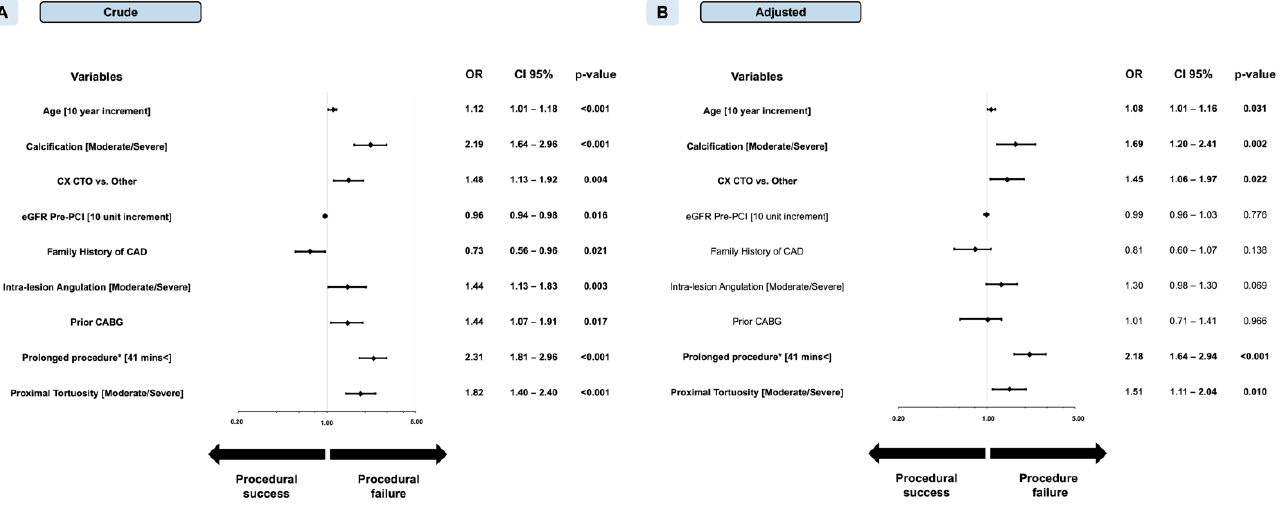
Figure 5. Forest plot of crude (Panel A ) and adjusted (Panel B ) odds ratios (OR) for prediction of procedural success in chronic total occlusion percutaneous coronary intervention (CTO PCI). CAD, coronary artery disease; CABG, coronary artery bypass graft; CTO, chronic total occlusion; CX, circumflex artery. * Indicates fluoroscopy time (min). Table 6. Multivariate analysis between secondary endpoints (technical success, major complica- tions, perforation, bleeding, 30-days MACE) and prolonged chronic occlusive (CTO) percutaneous coronary intervention (PCI) using the predefined cut-off minute value (< 41.0 min).